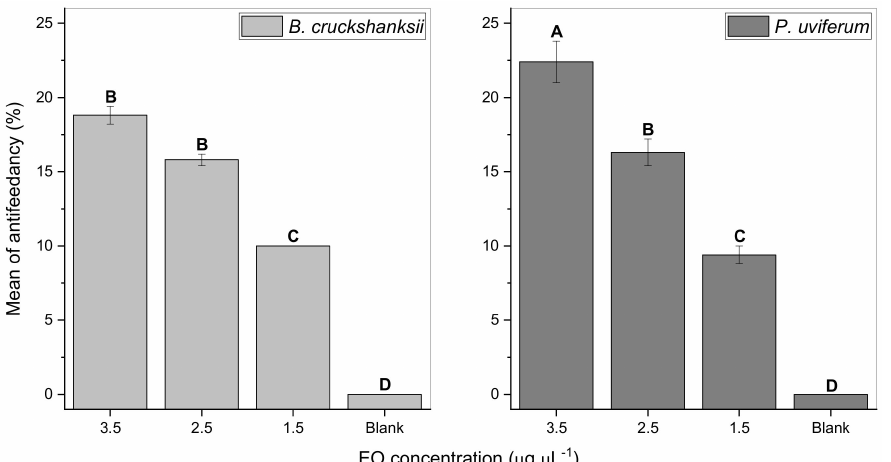
Figure 2. Antifeedancy levels of the B. cruckchanksii leaves and P. uviferum heartwood EOs against horn flies at three concentrations (1.5, 2.5, and 3.5 µ g µ L − 1 ) in laboratory bioassays compared to a blank. Values indicate the mean + SE. Letters on the columns indicate significant differences between the treatments and the blank based on the Tukey HSD test ( p ≤ 0.05), N =